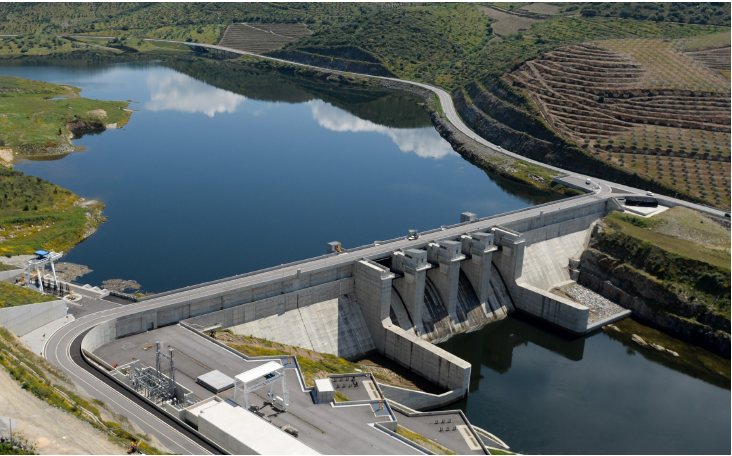
Figure 5. Overall view of the Feiticeiro